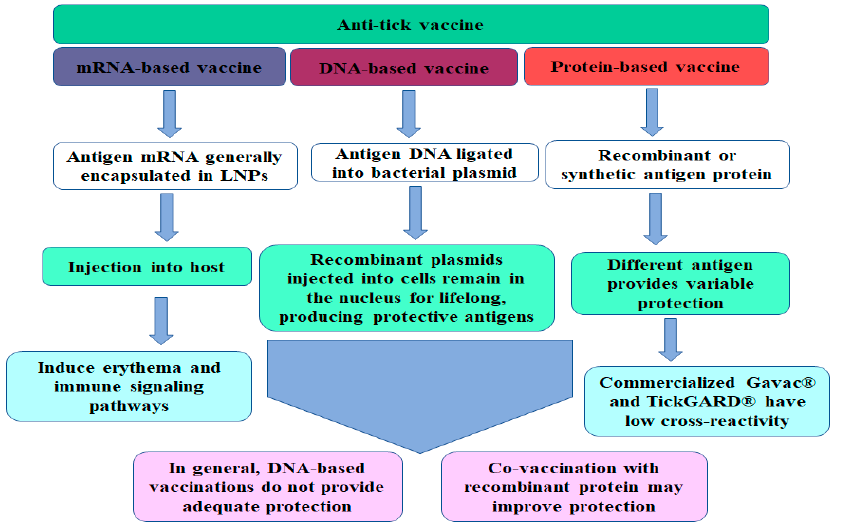
Figure 2. A schematic diagram representing the progress and development that has been made in the development of different anti-tick vaccines.